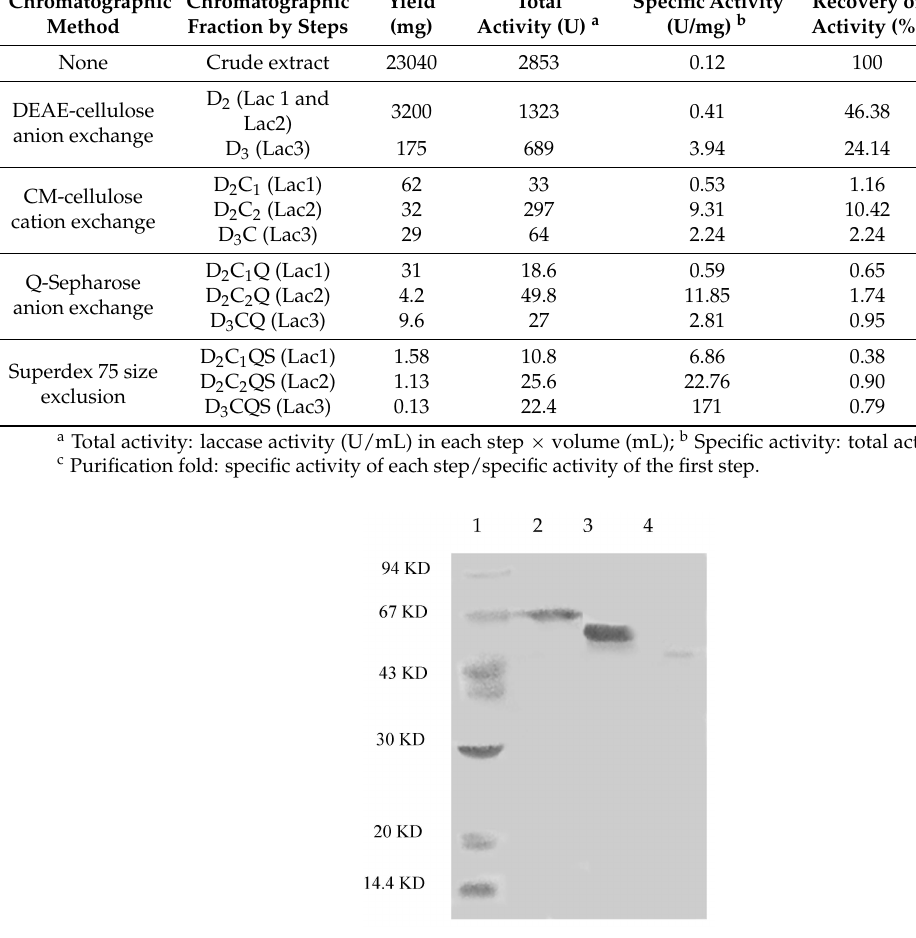
Figure 2. SDS-PAGE of isolated laccases. Lane 1: Molecular markers (GE Healthcare). From top to bottom: phosphorylase b (94 KD), bovine serum albumin (67 KD), ovalbumin (43 KD), carbonic anhydrase (30 KD), soybean trypsin inhibitor (20 KD) and lactalbumin (14.4 KD; Lane 2: Lac1; Lane 3: Lac2; Lane 4: